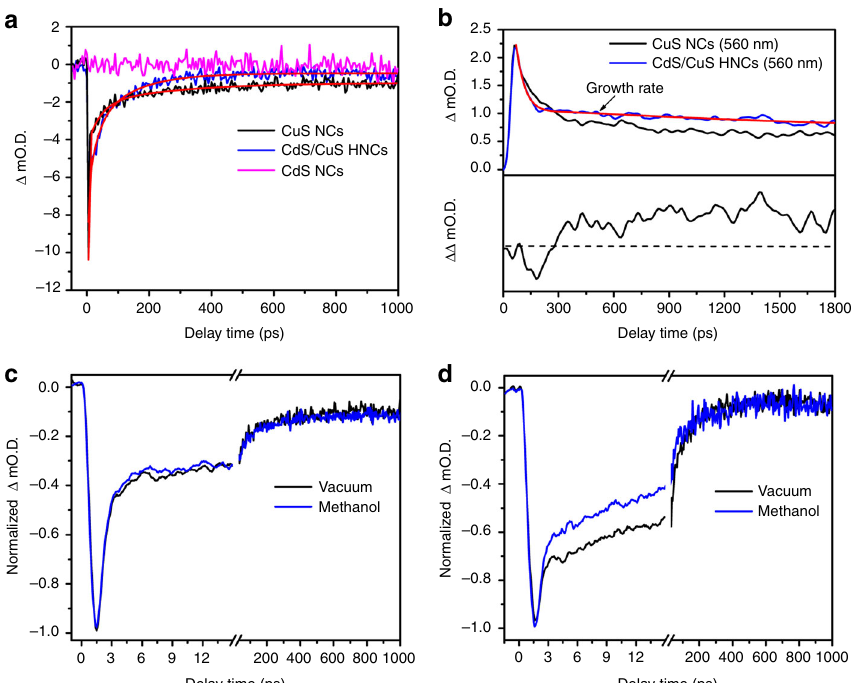
Fig. 3 Kinetic pro fi les and quenching study of nanocrystals after LSPR excitation. a Kinetic pro fi les of CuS nanocrystals (NCs), CdS NCs, and CdS/CuS heterostructured NCs (HNCs) at 1000 nm; red line is the best fi t. b Decay pro fi les of CuS NCs and CdS/CuS HNCs at 560 nm; red line is the best fi t. The rising component corresponds to the trapped holes in the CdS phase of CdS/CuS HNCs. c , d Quenching experiments by hole scavenger (methanol vapor: 20 Torr) for c CuS NCs and d CdS/CuS HNCs probing at 1000 nm. The Δ mO.D. means the change of optical density. Excitation wavelength: 1200